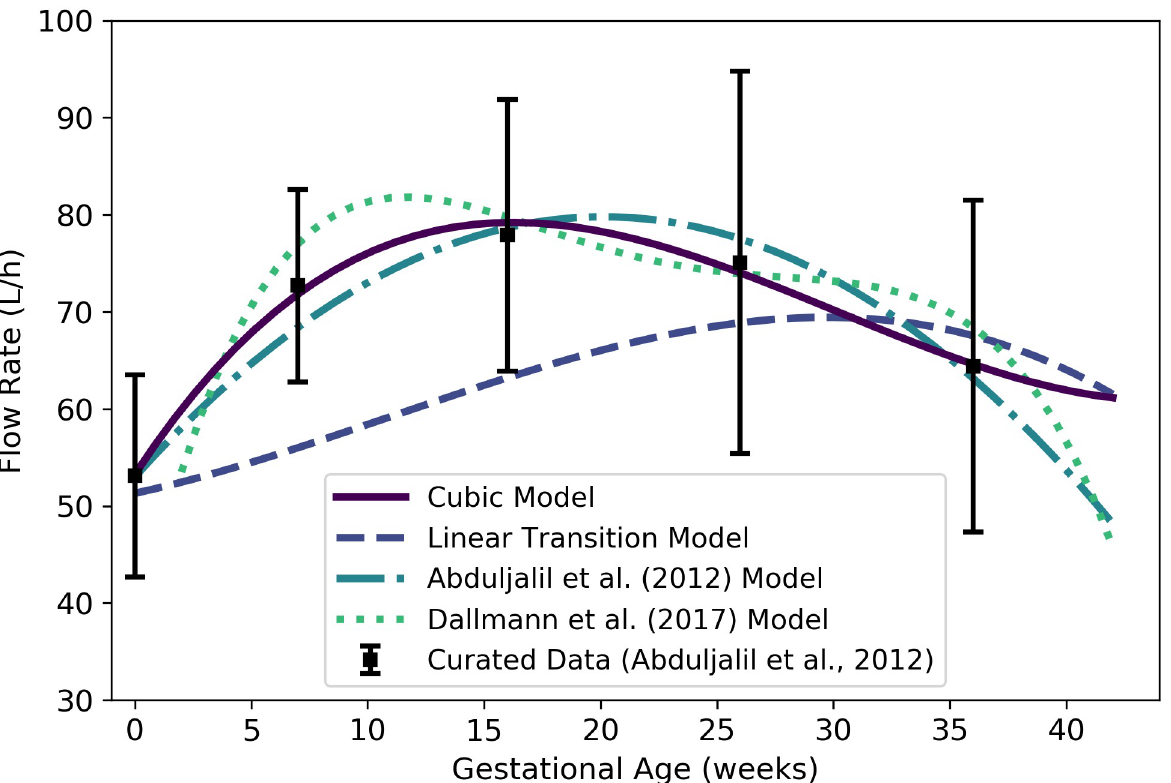
Fig 10. Maternal kidney blood flow vs. gestational age. The cubic model (solid line) given by Eq 17 was selected as the most parsimonious model in our analysis. The linear transition model given by Eq 16 is also shown. The model of Abduljalil et al. [28], which is a quadratic model, was calibrated using the same curated data set [28] used by us. Dallmann et al. [3] calibrated their model with different data.